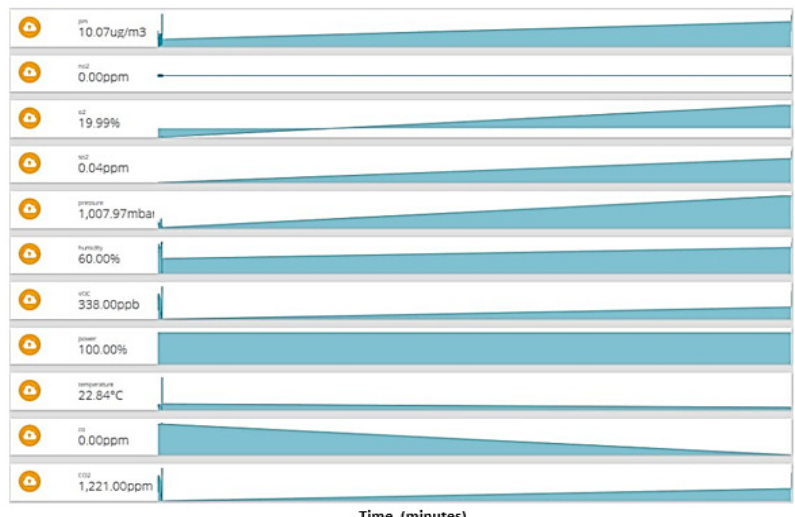
Figure 5. The SeReNo2 IoT Dashboard at Ubidots IoT.